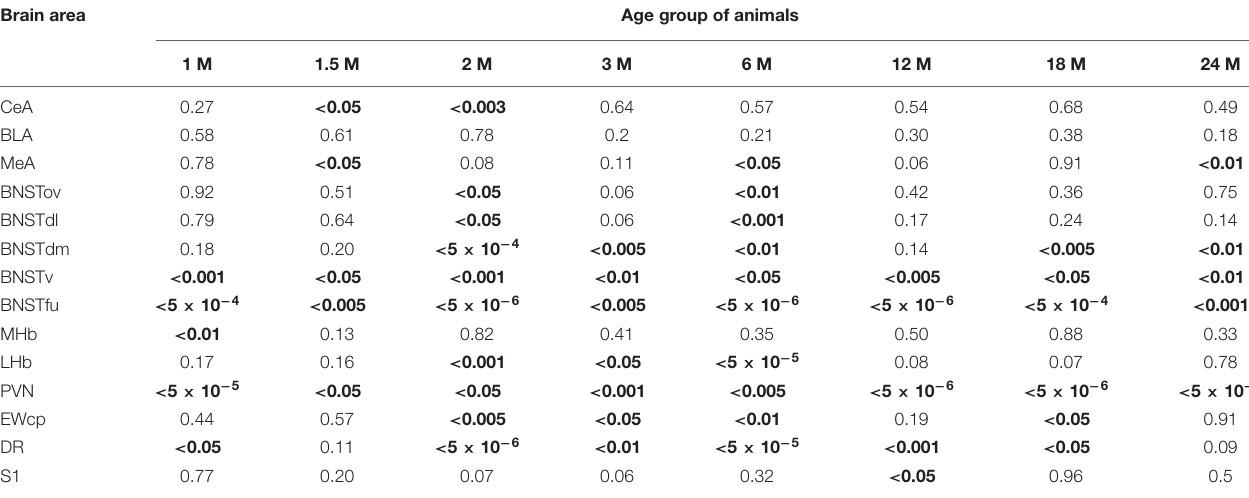
TABLE 5 | Summary of the p -values of t -tests in the ARS model. Brain area